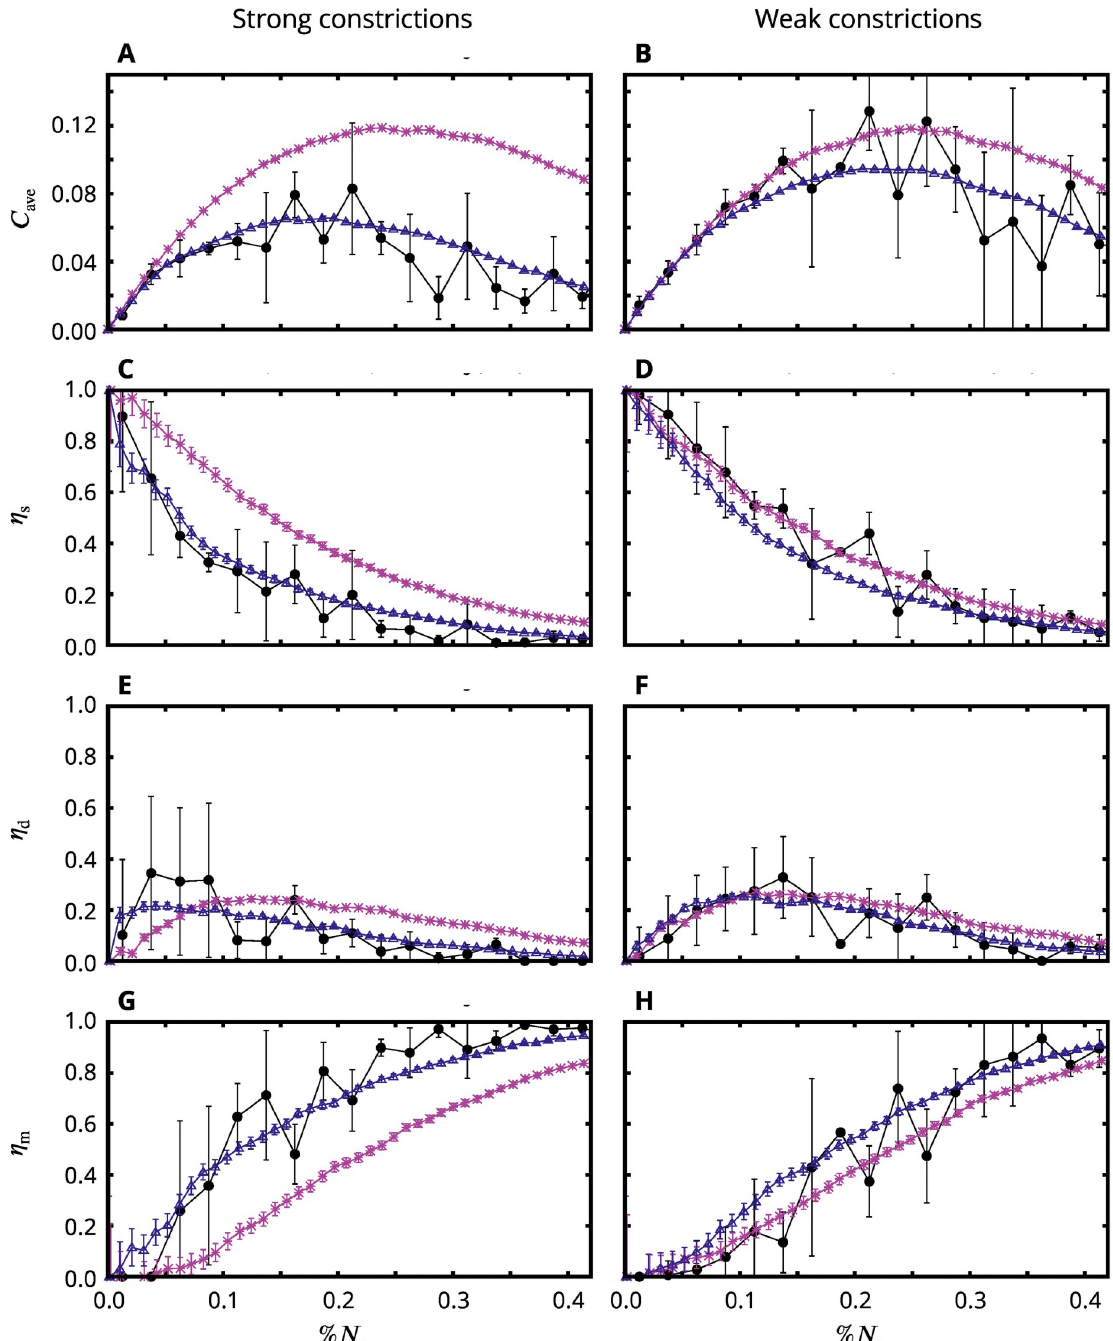
Fig 9. Constricted-cell cluster counts in the AGF model and in vivo . ( A,B ) Normalized average number of clusters C ave , ( C,D ) average fraction of particles in singlets, η s , ( E,F ) doublets, η d , and ( G,H ) multiplets, η m . Simulations with strong constrictions (left) weak constrictions (right) vs the fraction of active constricted cells % N c . Tensile feedback (purple triangles); random uncorrelated system (pink stars). The stress sensitive system uses the coupling parameter β = 250 and constriction factors f c = 0.6 (strong constrictions) and f c = 0.85 (weak constrictions). Strong constrictions in vivo were identified using the constriction threshold r c = 0.65, and weak constrictions using r c = 0.85. The experimental data (black circles) agree with the numerical predictions for the system with tensile-stress feedback but not with the random uncorrelated system. Embryos ( n = 5); simulations ( n = 10). Error bars: SD. For simulations, the error bars are smaller than the symbols representing the data points.